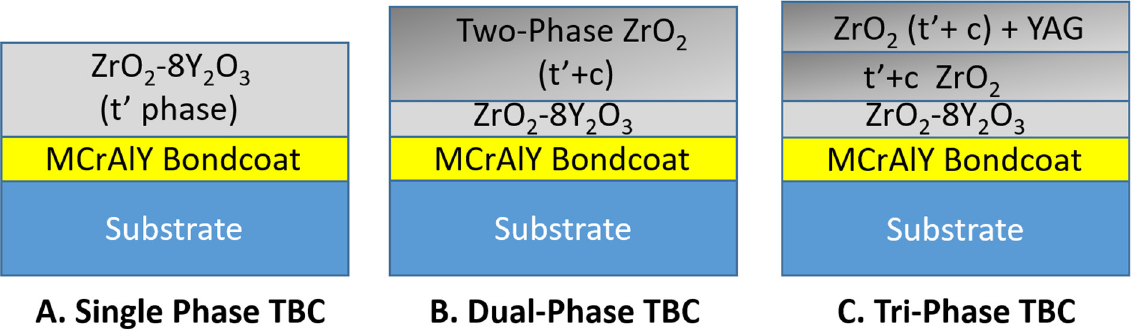
Figure 4. Schematics of the coating structures of the single, dual, and tri-phase composite